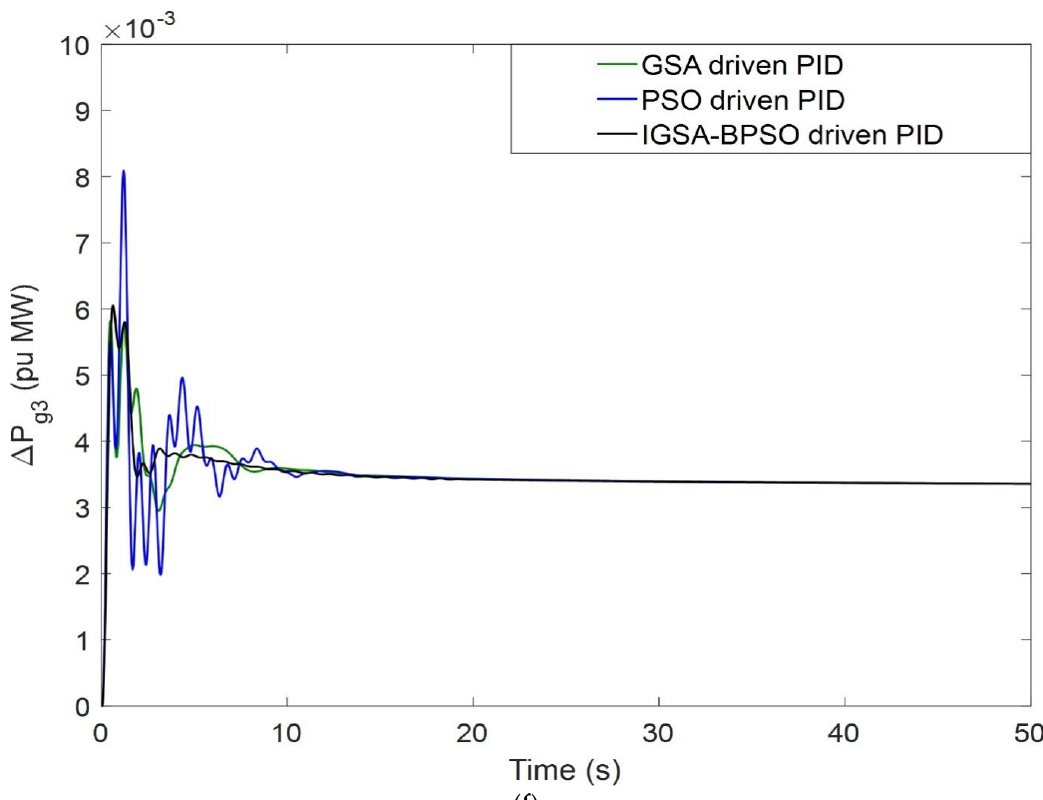
Figure 14. ( a ) Dynamic responses of Δ F 1 under addition of AC-DC tie line; ( b ) dynamic responses of Δ F 2 under addition of AC-DC tie line; ( c ) dynamic responses of Δ P tie under addition of AC-DC tie line; ( d ) dynamic responses of Δ P g1 under addition of AC-DC tie line; ( e ) dynamic responses of Δ P g2 under addition of AC-DC tie line; ( f ) dynamic responses of Δ P g3 under addition of AC-DC tie line. Table 10. Summary results for different cases related to uncertainties and dynamic